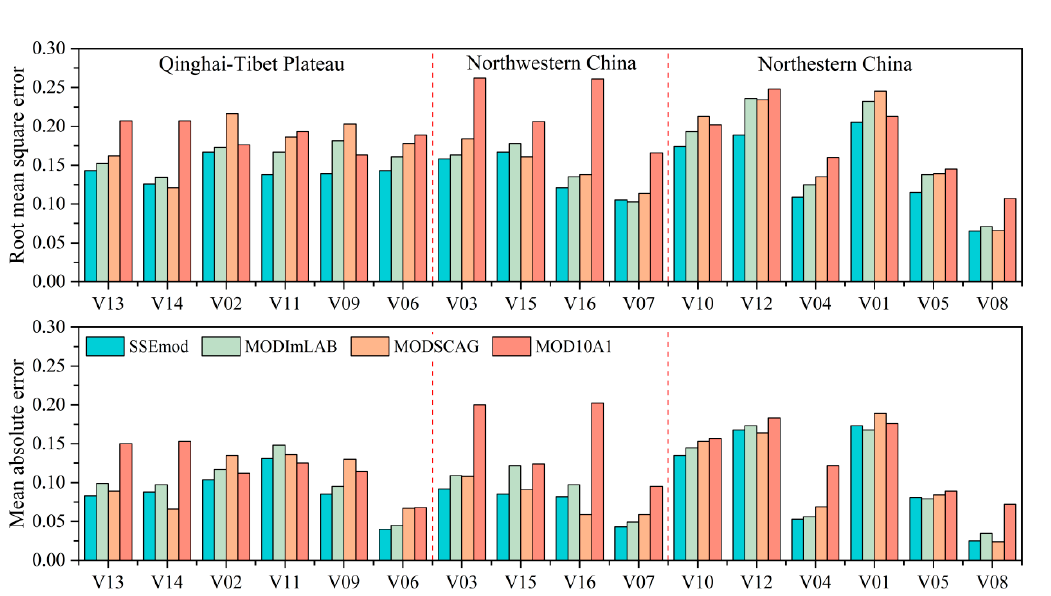
Table 1. The average accuracy validation results of different metrics of different methods for FSC retrieval in three snow-covered regions of China.